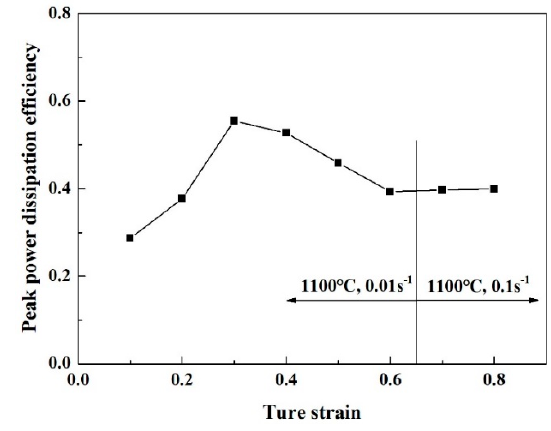
ffi ciency and true